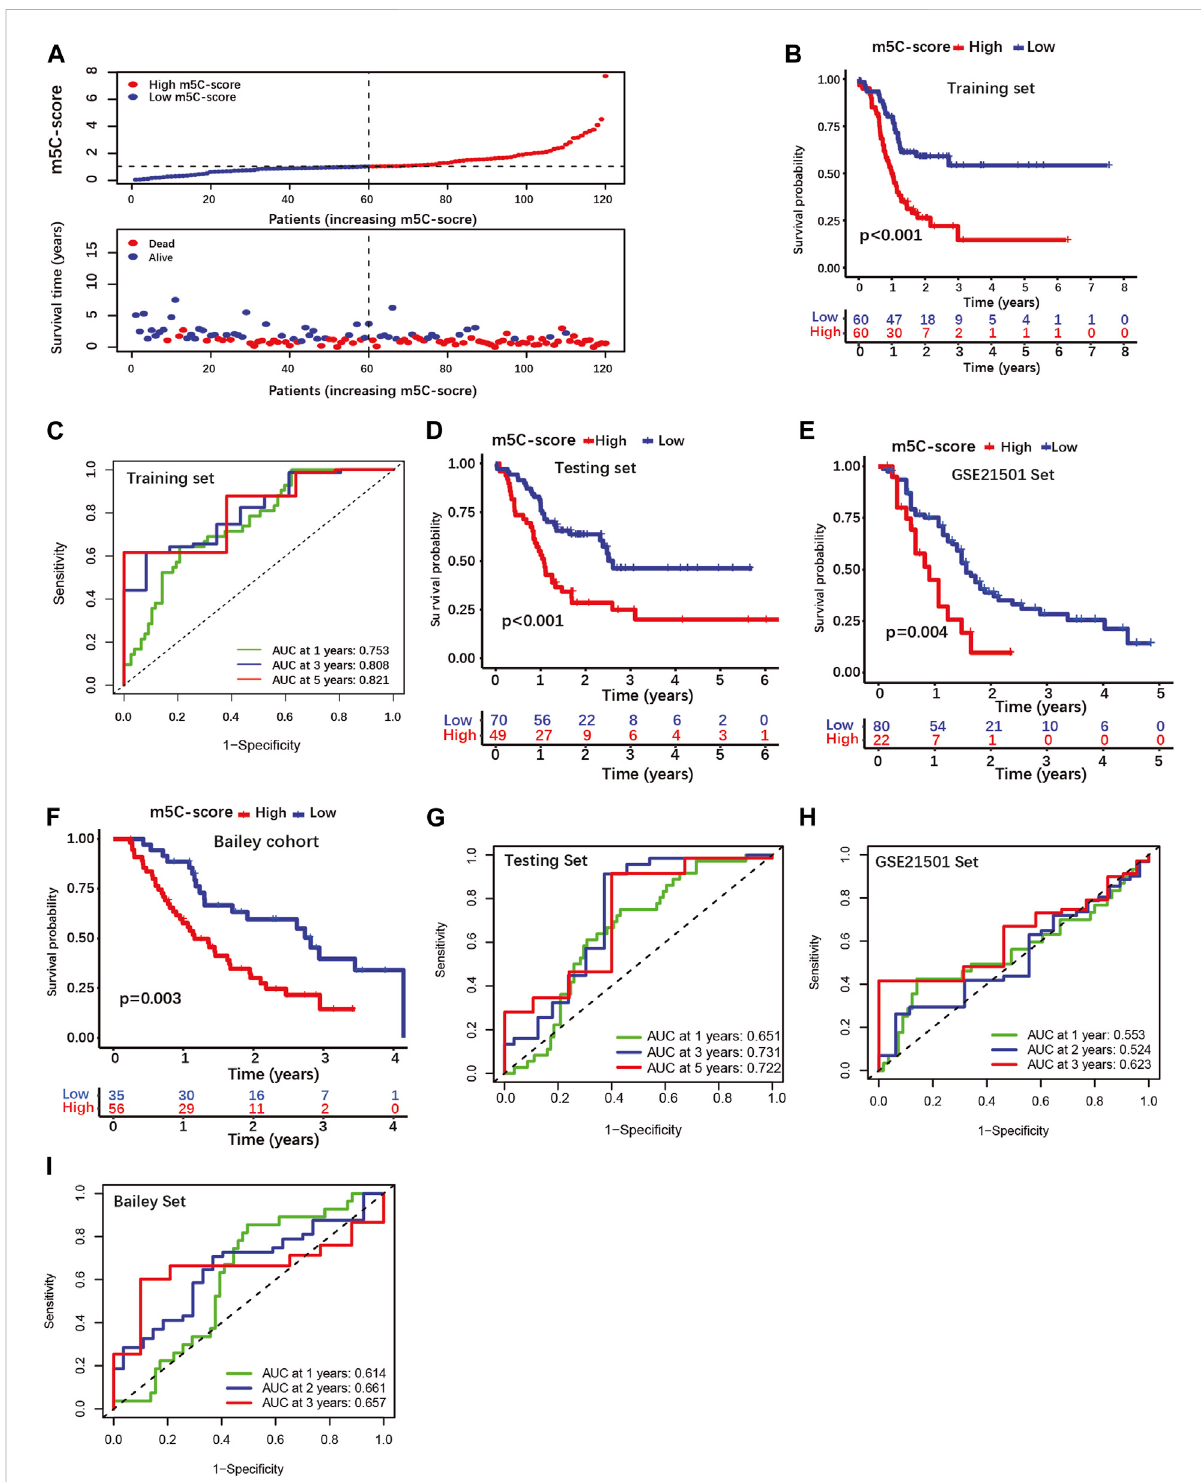
FIGURE 3 Construction and validation of a four-gene scoring signature (m5C-score) prognostic model. (A) Distributions of PDAC patients and survival statusaccordingtom5C-scoreinthetrainingset. (B) K-McurvesillustratingOSaccordingtothem5C-scoreanalyzedbylog-ranktestinthetraining set. (C) ROC curves for m5C-score prediction of OS at 1, 3 and 5 years in the training set. (D – F) K-M curves illustrating OS according to the m5C- score analyzed by log-rank test in the testing set and external cohorts (GSE21501 set, Bailey cohorts). (G – I) ROC curves of m5C-score prediction of OS at 1, 3 and 5 years in the testing and external